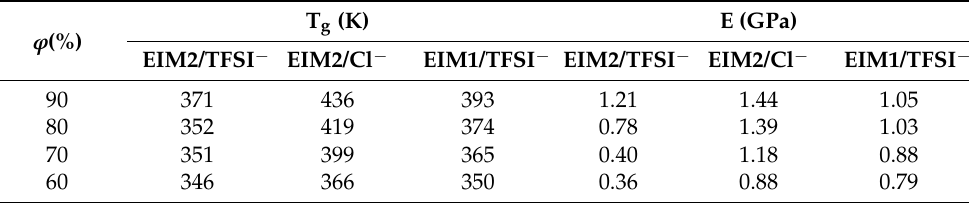
Table 1. Glass transition temperatures Tg (in K) and Young’s modulus E (in GP) for poly(ionic liquid)s according to the degree of cross-linking ϕ (%). The poly(ionic liquid)s consist